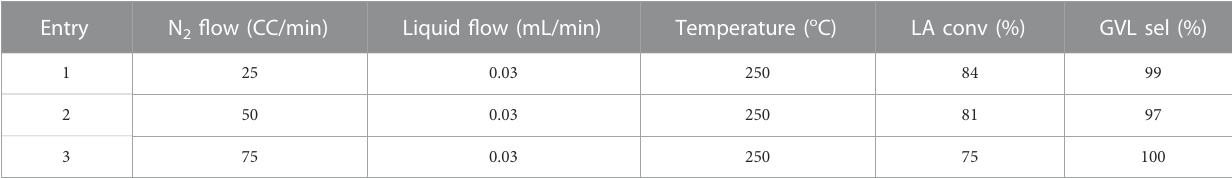
TABLE 3 In fl uence of space velocity on conversion of LA to GVL. Entry